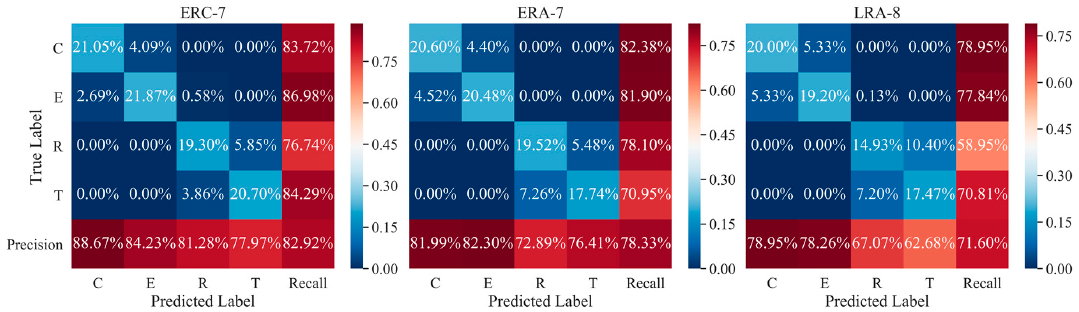
Figure 11. Confusion matrices of different combination strategies at their best performance.